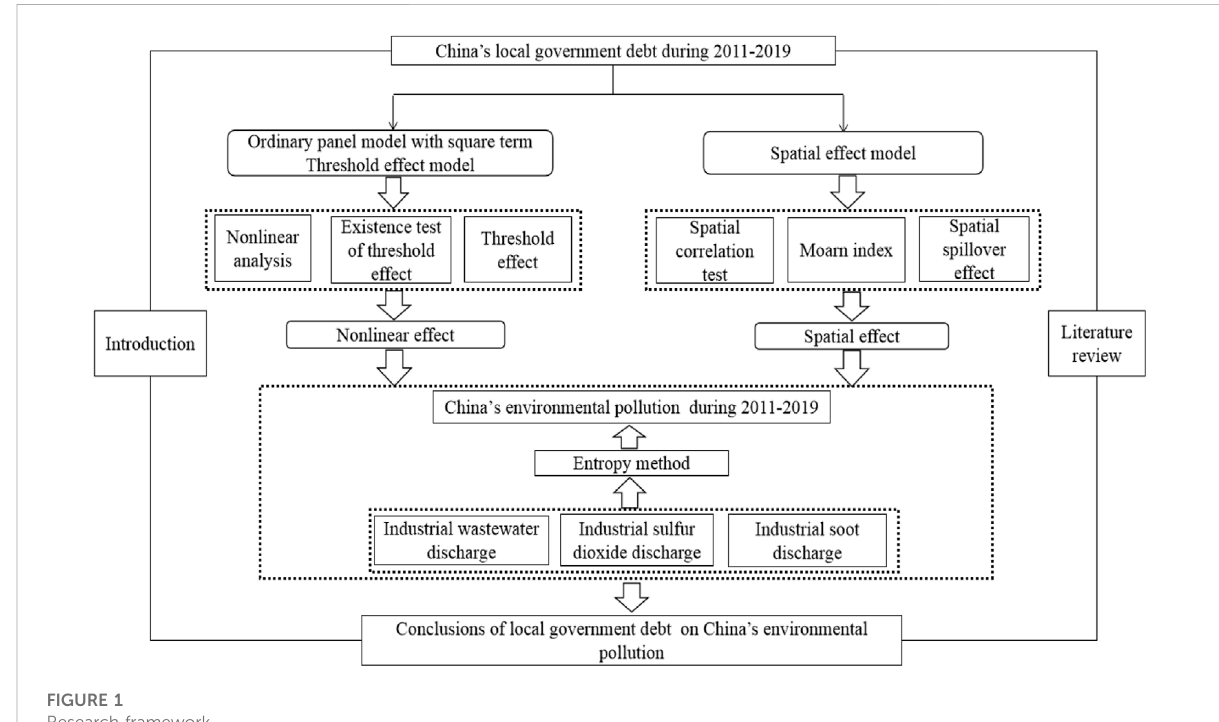
FIGURE 1 Research